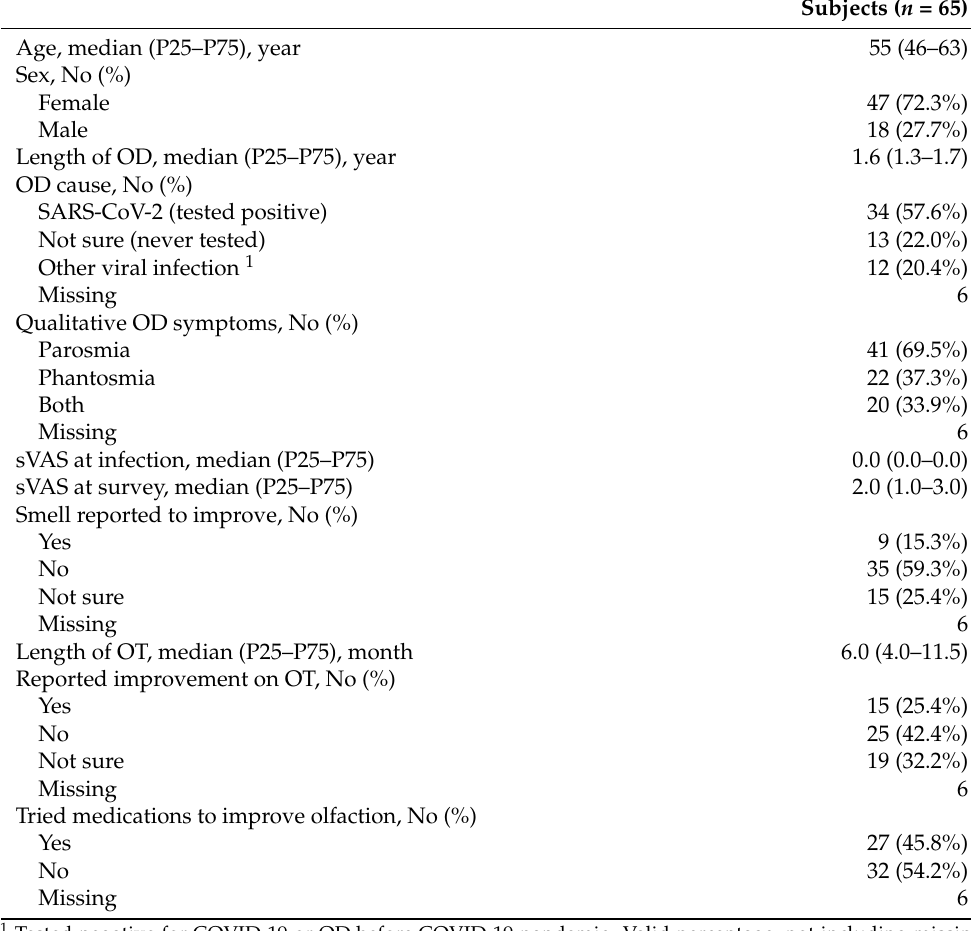
Table 1. Characteristics of the